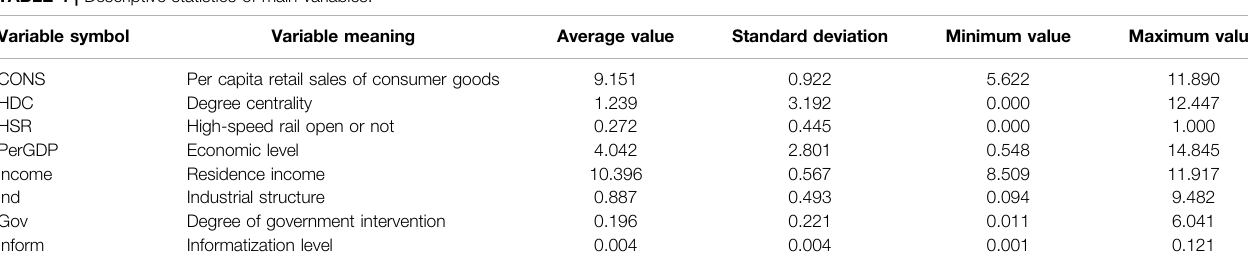
TABLE 4 | Descriptive statistics of main